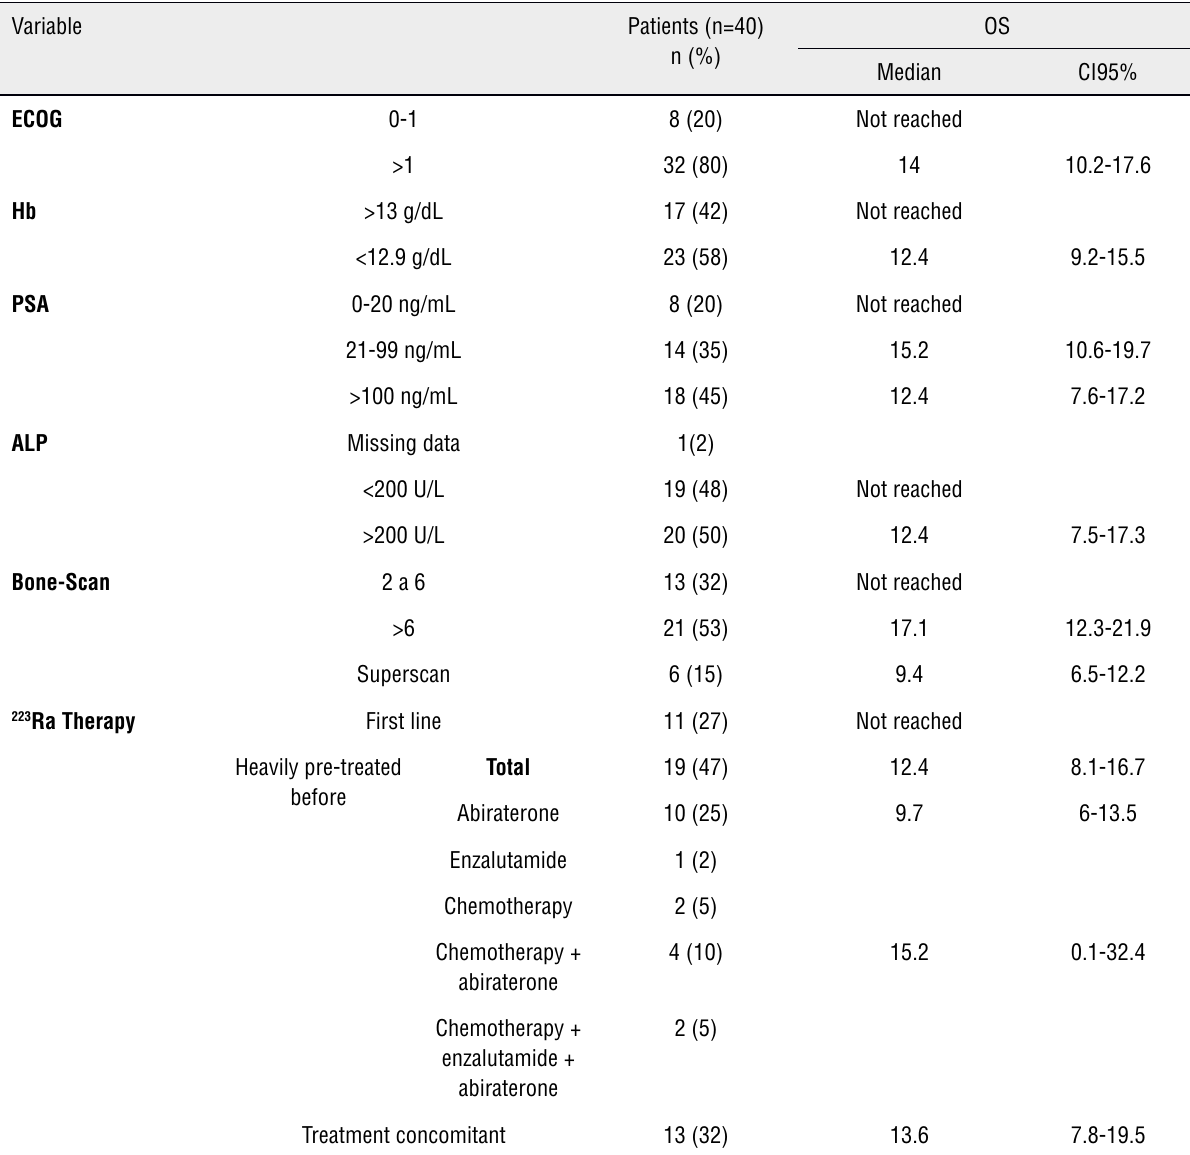
Table 4 - Univariate analysis of OS in relation to baseline variables. Variable Patients